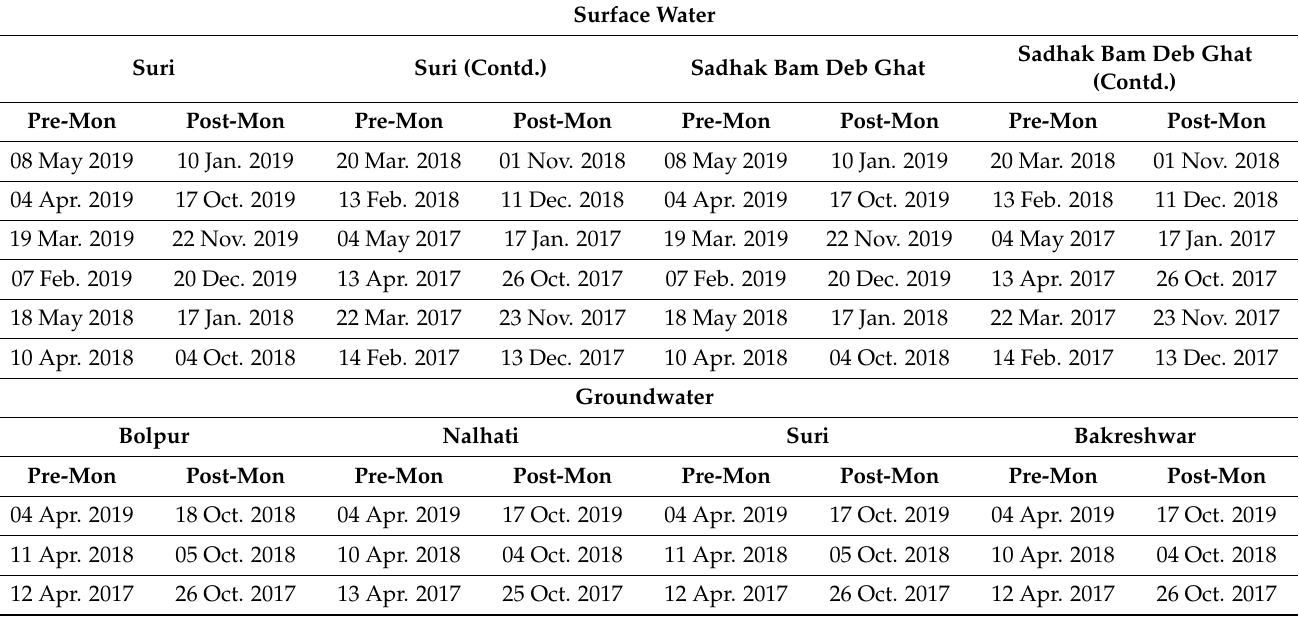
Table 1. Dates of surface and groundwater